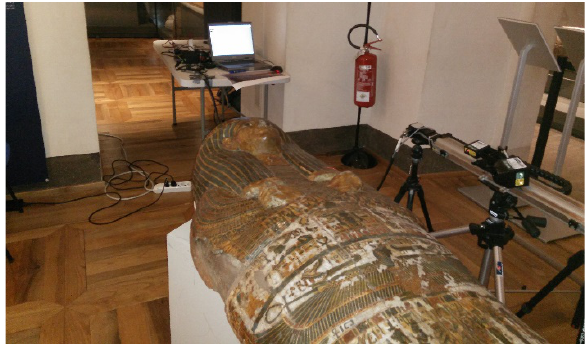
Figure 3. The coffin during the scanner